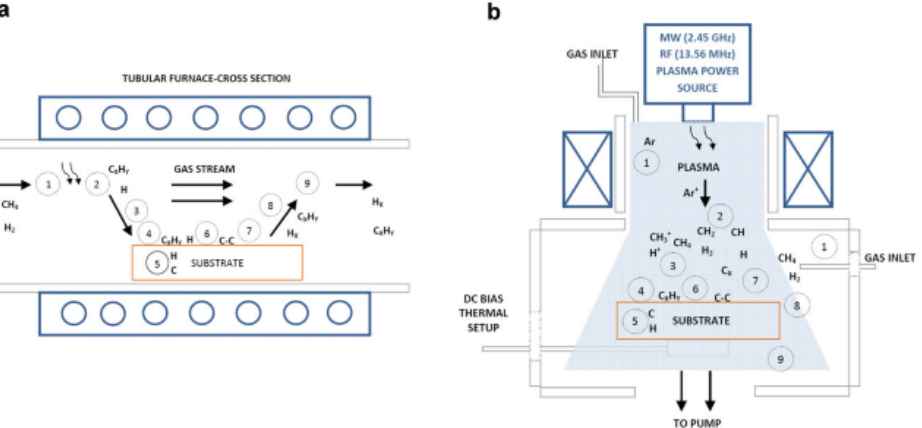
Figure 6. ( a ) Thermal CVD ( b ) plasma assisted CVD(PACVD). (1) Forced convection of reactants. (2) ( a ) thermal ( b ) plasma activation. (3) Gaseous diffusion of reactants. (4) Adsorption. (5) Dissolution and bulk diffusion. (6) Thermally assisted surface processes. (7) Desorption. (8) Diffusion of by-products. (9) Forced convection of product. “Reproduced with permission from [83], [Chemical Vapor Deposition]; published by Wiley, 2013”.